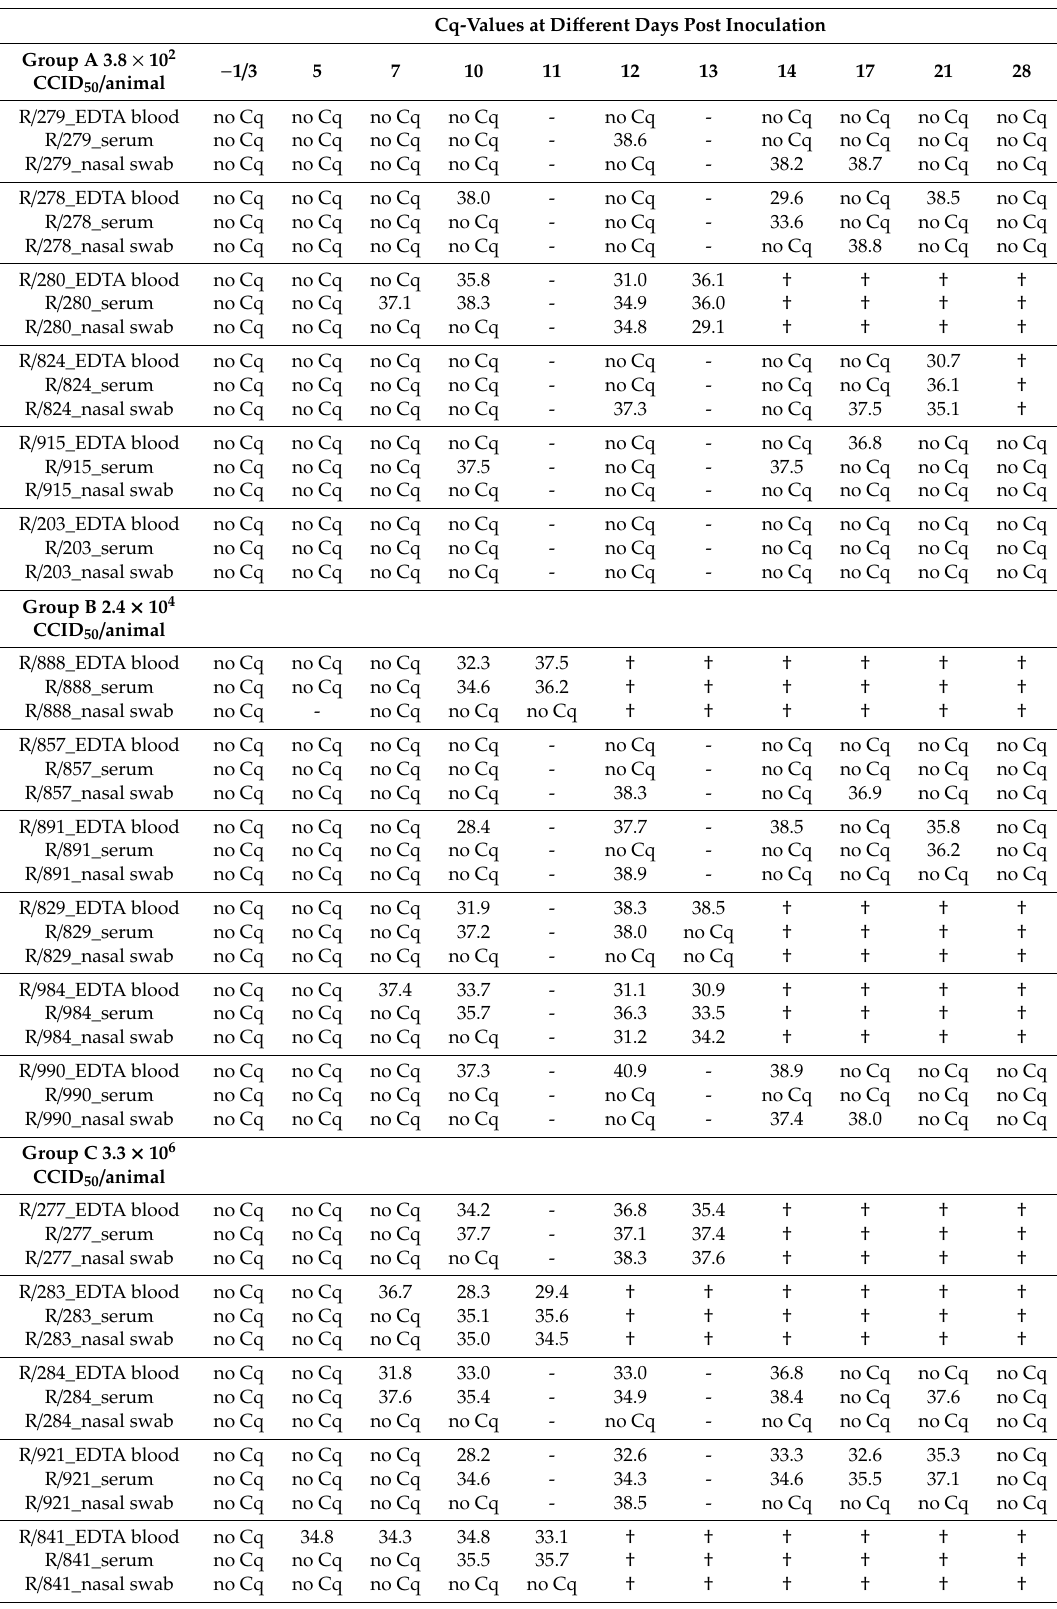
Table 2. Pan Capripox real-time qPCR: Results of di ff erent sample materials after inoculation with di ff erent infective doses of LSDV-strain